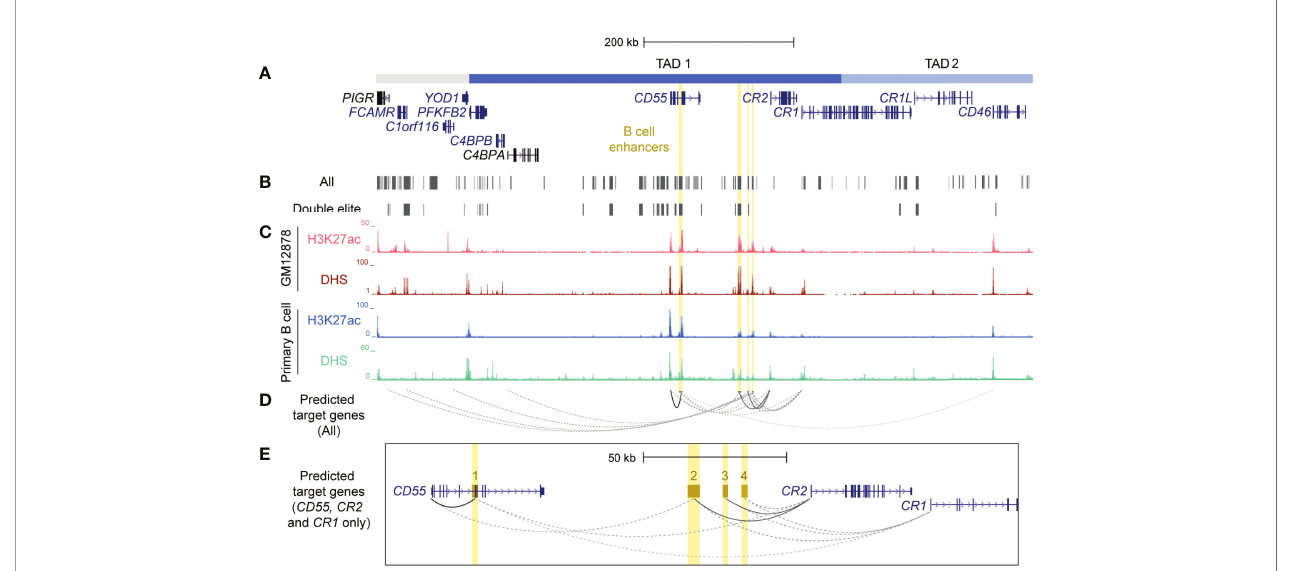
FIGURE 3 | Identi fi cation and prioritisation of candidate B cell enhancers in TAD 1. (A) The structural organisation of the RCA genes (dark blue) and upstream genes (grey) PIGR, FCAMR, C1orf116 and YOD1 on hg19 (chr1:207,104,491-207,978,031). (B) Putative enhancers were identi fi ed by GeneHancer from multiple datasets from different consortia, such as ENCODE, Ensembl and FANTOM5 (GeneHancer). Each putative enhancer was also assigned predicted gene targets based on one or more methods. However, only a subset of putative enhancers were classi fi ed as ‘ double elite ’ on GeneHancer (Double elite). (C) Four candidate B cell enhancers (yellow) were identi fi ed using human ENCODE data for H3K27ac enrichment and DNase I hypersensitivity in different B cell samples (GM12878 B cell line and primary B cells from peripheral blood). (D) Candidate B cell enhancers were predicted to regulate multiple genes. Target gene predictions that were identi fi ed by more than one method in GeneHancer are represented by a solid line. Predictions that were identi fi ed by just one method are represented by a dotted line. The opacity of each line represents the relative score/con fi dence for each gene-enhancer prediction as determined by GeneHancer whereby higher con fi dence predictions are darker. Scores determined by GeneHancer are listed in Supplementary Table 5 . (E) Region across CD55, CR2 and CR1 (exon 1 – 6) on hg19 (chr1:207,484,047-207,700,935). Candidate B cell enhancers (BEN) were named based on order of chromosomal position (BEN-1, BEN-2, BEN-3 and BEN-4). Evidence for BENs to regulate CD55, CR2 and CR1 was strongest among all gene-enhancer predictions.